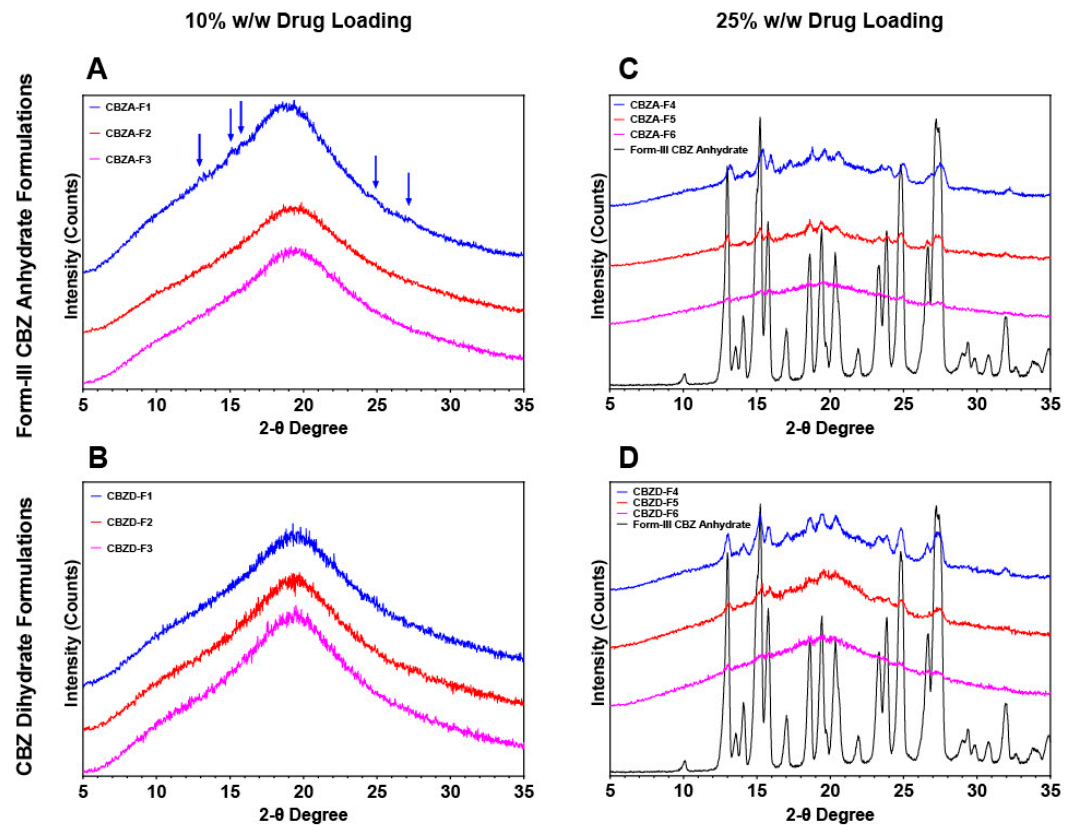
Figure 5. Degree of crystallinity of formulations of CBZ dihydrate and form-III CBZ anhydrate at two drug loadings measured by XRPD. A . 10% form-III CBZ anhydrate formulations; B . 25% form-III CBZ anhydrate formulations; C . 10% CBZ dihydrate formulations; and D . 25% CBZ dihydrate formulations.